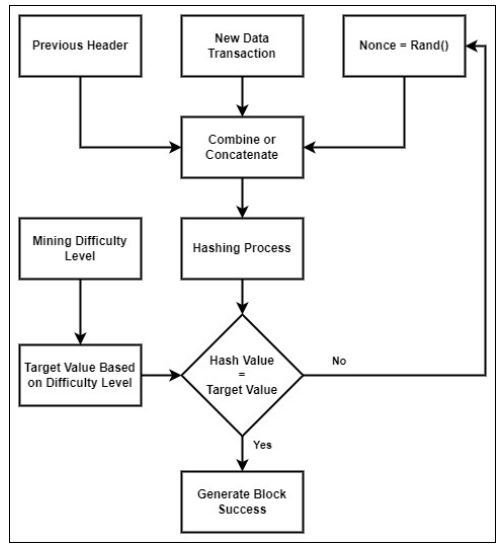
Figure 2. The miner puzzle-solving algorithm. Table 1. SimBlock simulator parameter setting.